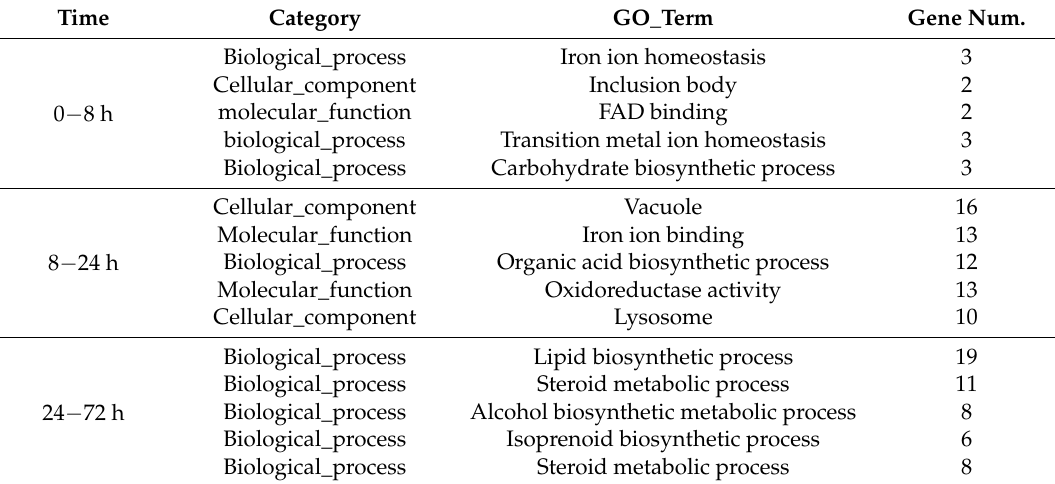
Table 3. Results of GO enrichment during the three stages following infection.